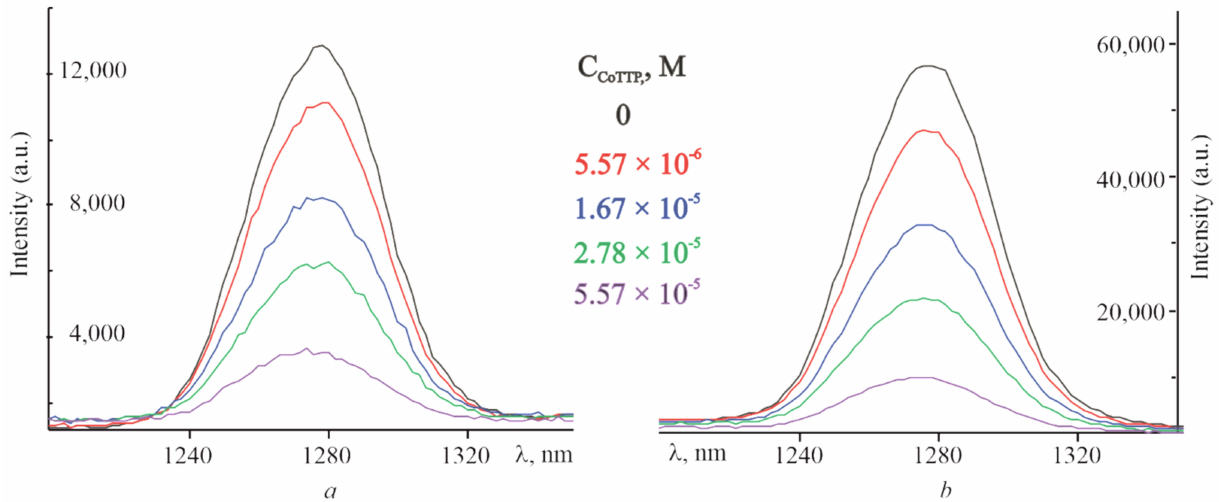
Figure 4. The emission spectra of singlet oxygen formed by the sensitization with C 60 ( a ), PyC 60 ( b ),